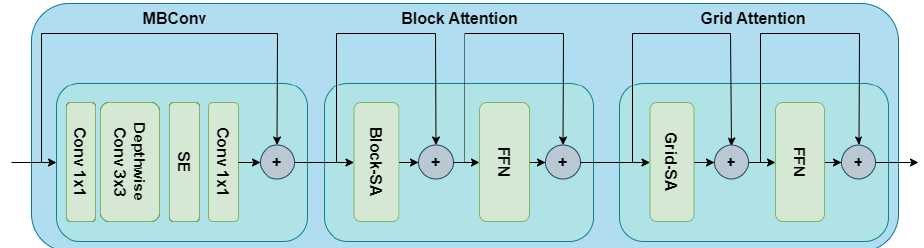
Figure 5. MaxViT block to capture both local and global attention information